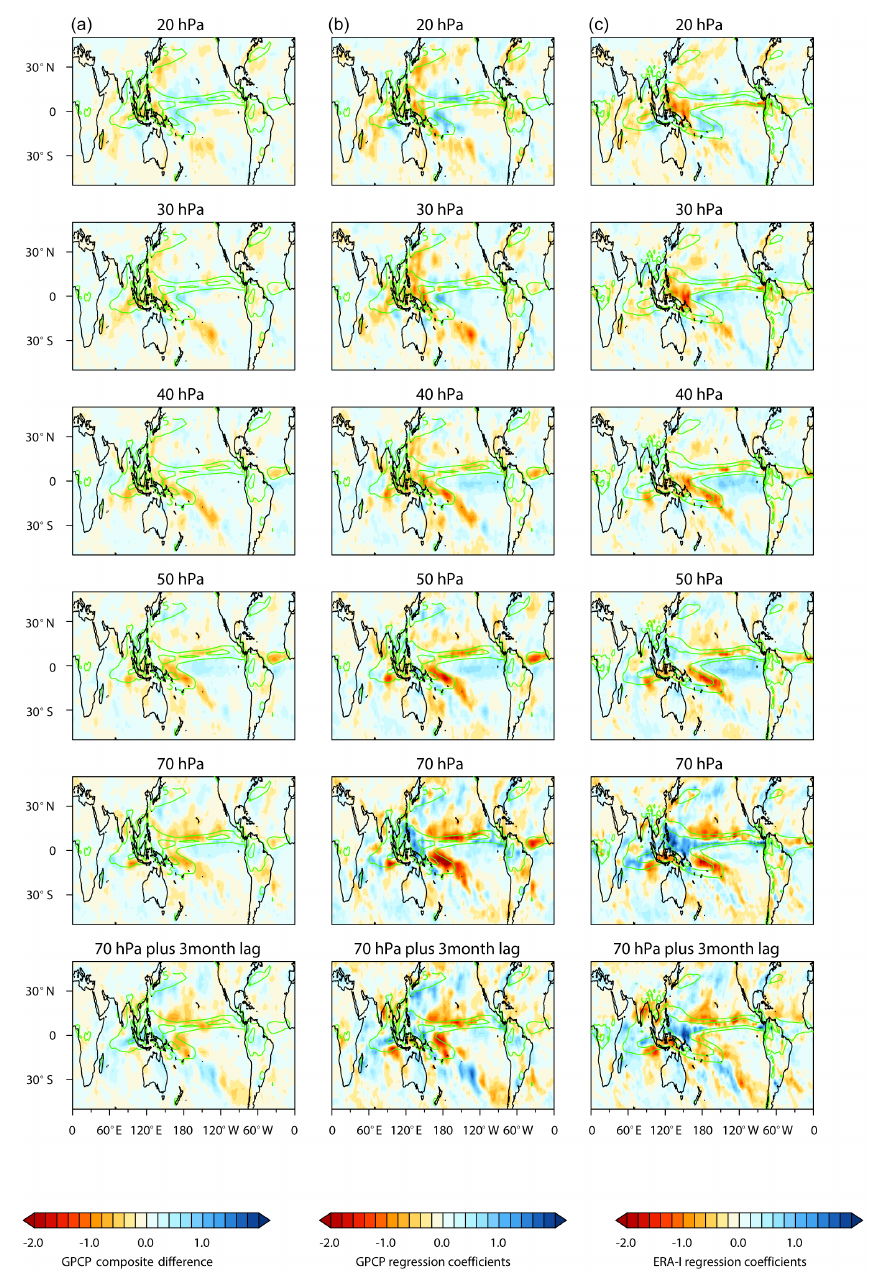
Figure 9. Left column: latitude–longitude distributions of annually averaged W–E QBO composite differences in precipitation (mmday − 1 ) using the GPCC dataset for 1979–2016. Middle column: corresponding regression analysis of the GPCC dataset for 1979–2016. Right column: corresponding regression analysis of total precipitation data from the ERA-I dataset for 1979–2016. The rows show results for the QBO defined by the equatorial zonal wind time series U eq at different pressure levels from 20 to